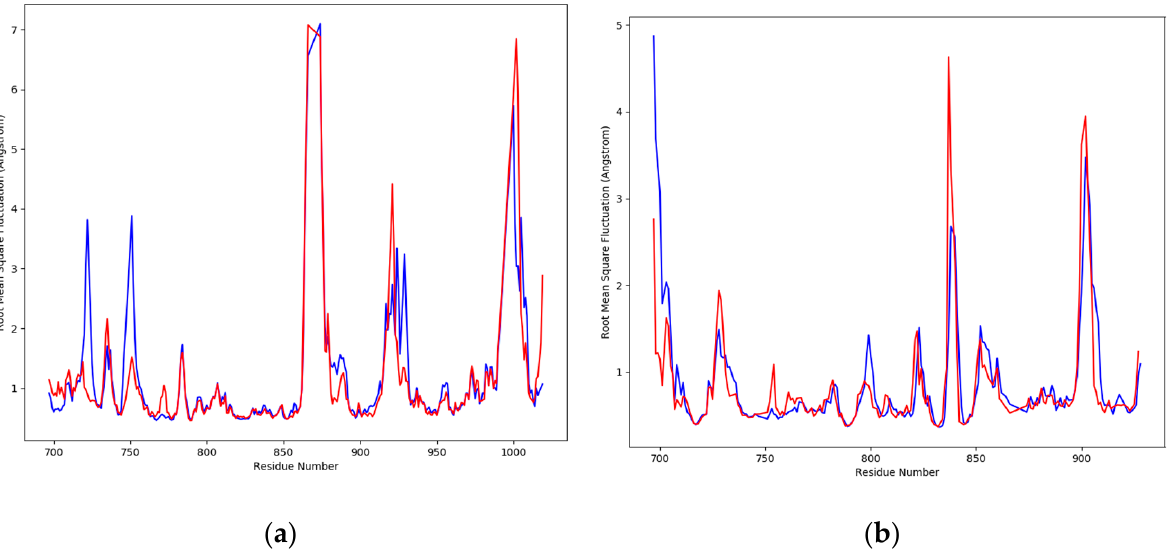
Figure 7. The plots of residue wise root mean square fluctuation (RMSF) of receptor proteins in apo and bound states. ( a ) RMSF plot of EGFR protein (in apo and bound state) and ( b ) RMSF plot of caspase-9 protein (in apo and bound state). The red peaks are showing apo proteins, while the blue peaks are showing values for bound states.